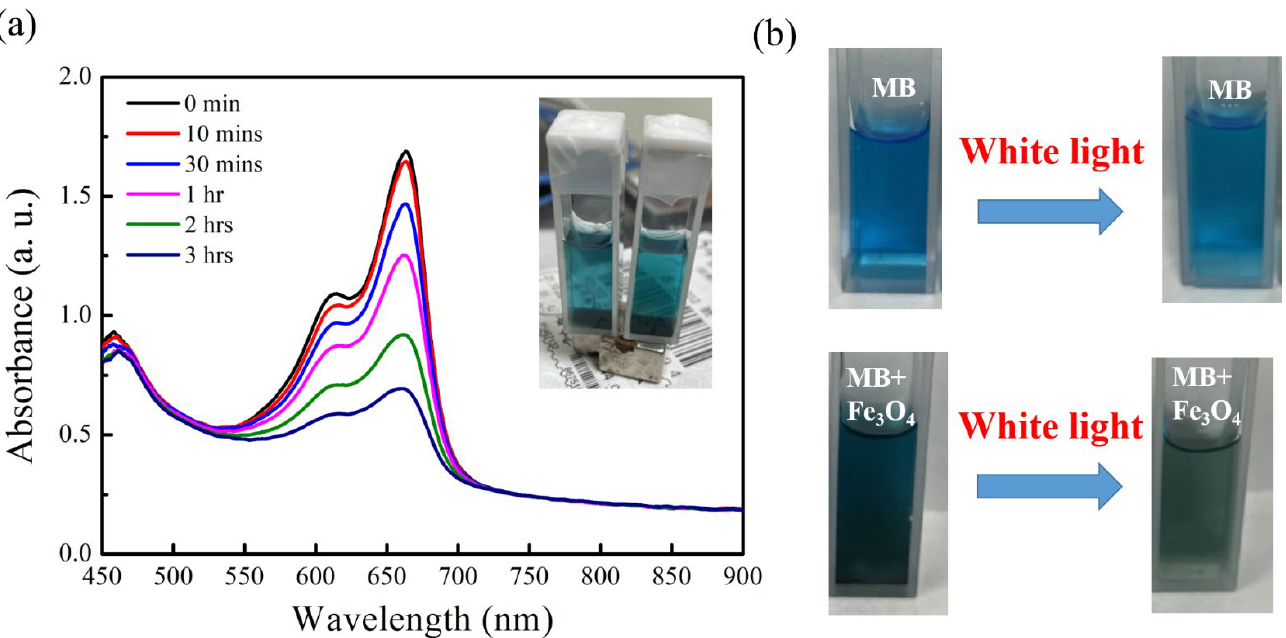
Figure 6. ( a ) Spectral change in methylene blue (MB) absorbance under white-light illumination. The photograph (inset) also shows the condensation of magnetic NPs under magnetization. ( b ) Photographs of MB without and with addition of magnetic Fe 3 O 4 NPs after 30 min white-light illumination.